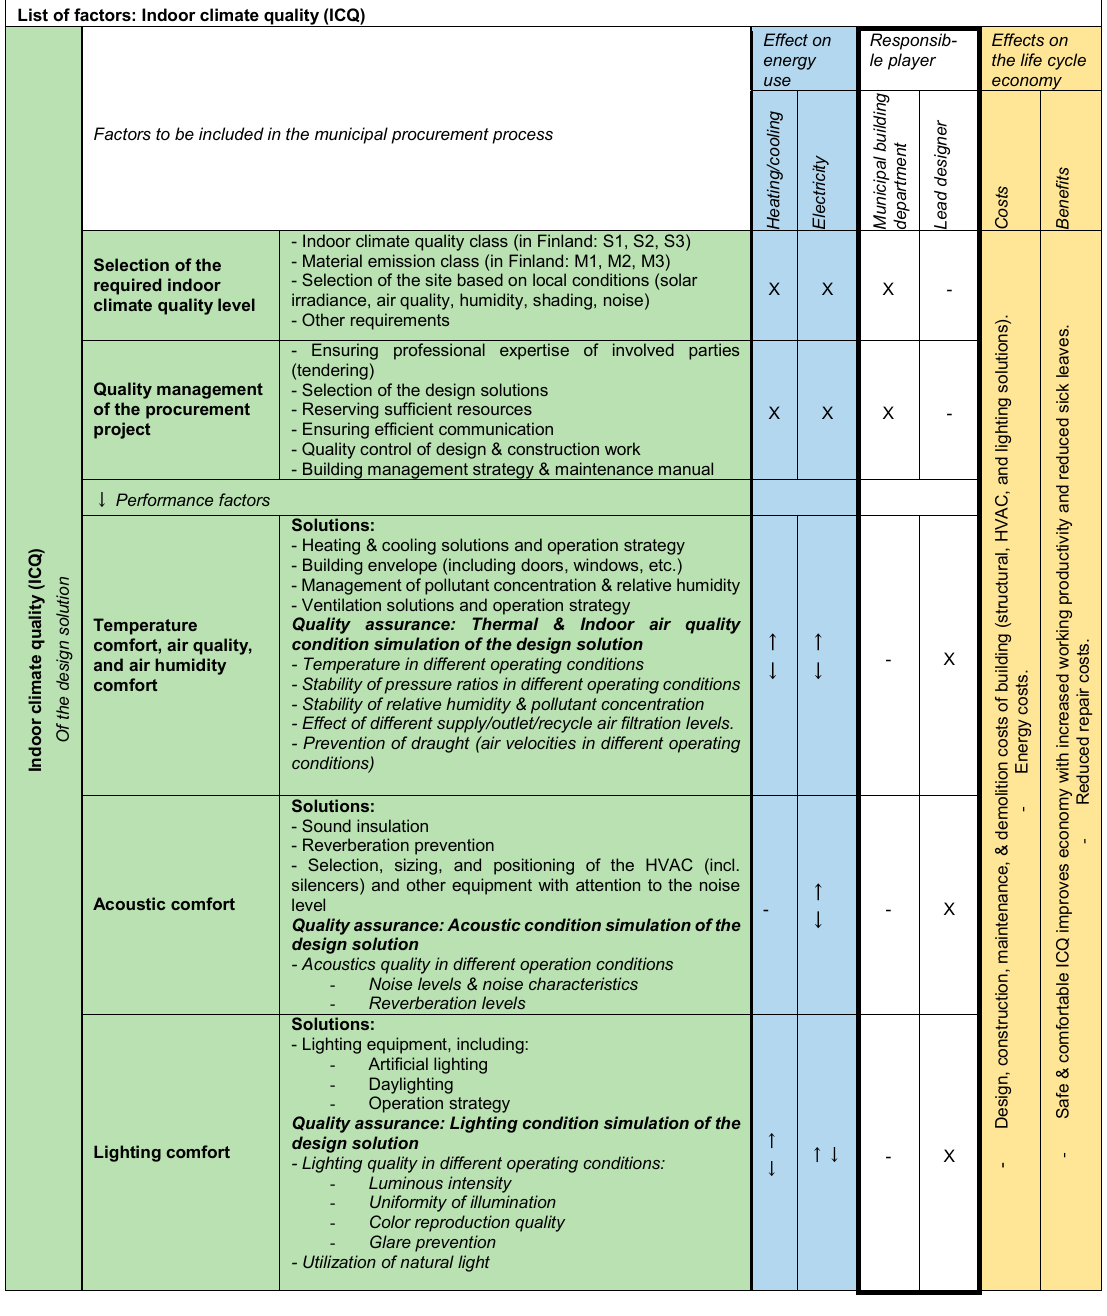
Figure 8. The energy efficiency responsibilities in the design of the municipal building: Indoor climate quality. Based on